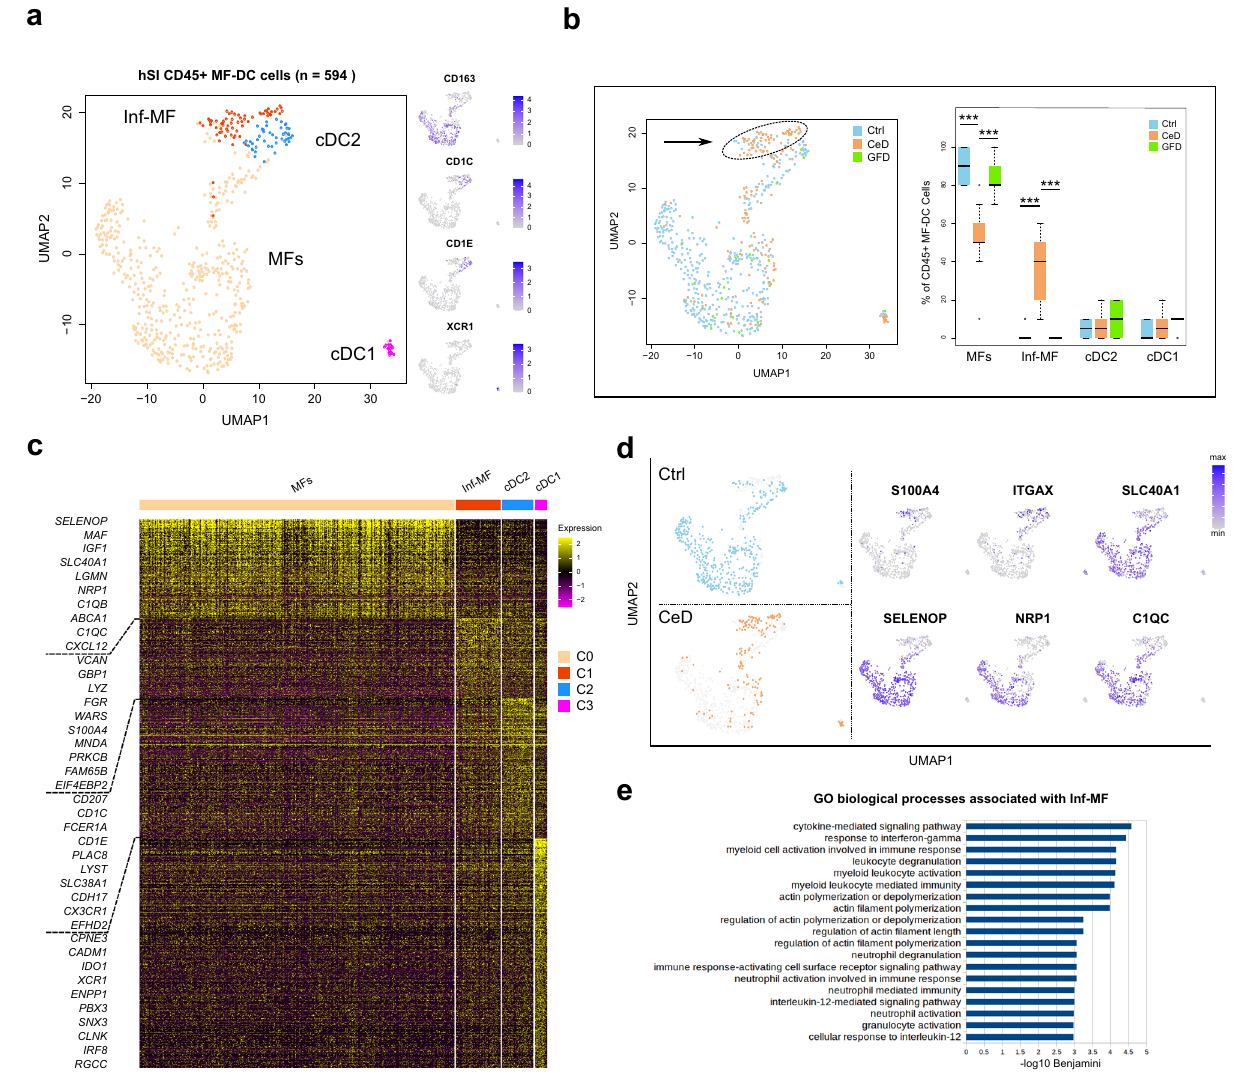
Fig. 2 | Single-cell landscape of MF-DC cells in Lamina Propria of human small intestine in Ctrl, CeD and GFD samples. a UMAP clustering plot of CD45 + Mac- rophage/Dendritic (MF-DC) cells in Lamina Propria (LP) of Ctrl (control subjects), CeD(Celiacdiseasepatients)andGFD(Celiacpatientsongluten-freediet)samples with side scatter plots of canonical gene expressions (MF Macrophage, Inf-MF In fl ammatory Macrophage, cDC classical Dendritic cell). b Projection of Ctrl, CeD andGFDcellsontheUMAPplot(leftscatterplot)andboxplots(right)showingthe percentage of the MF-DC single cells across the UMAP clusters from Ctrl, CeD and GFD derived cells (center line, median; box limits, upper and lower quartiles;